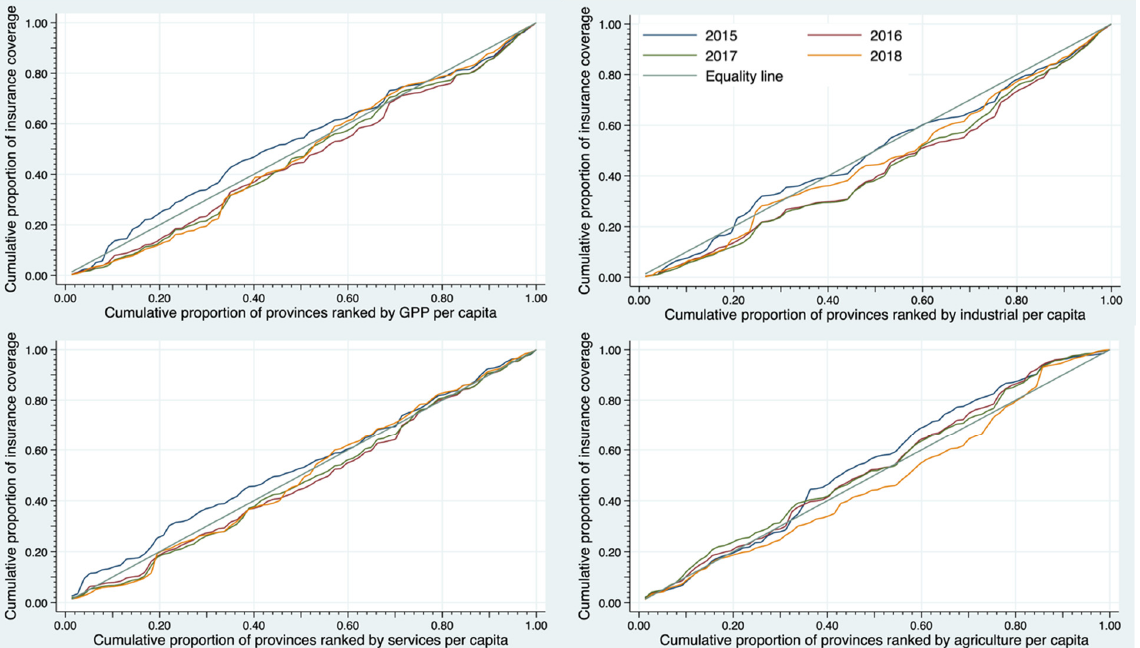
Figure 4. Concentration curve of SSS coverage among all migrants and GPP per capita and concentration curve of SSS coverage and the rank of provincial economic contribution by industrial sector, service sector, and agricultural sector, 2015 to 2018.